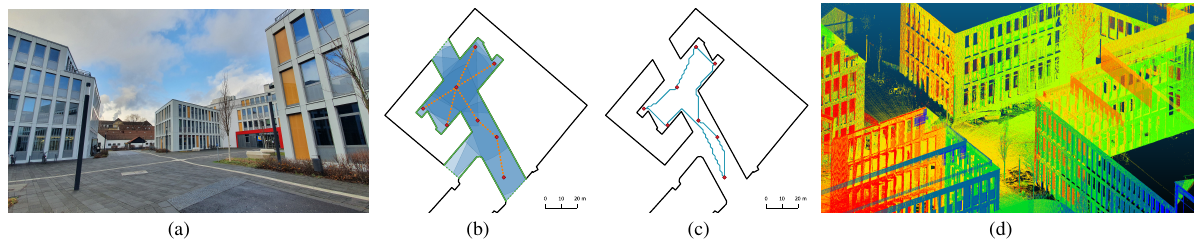
Figure 1. Illustration of the real-world application of our pipeline on the building complex as shown in (a). Given the boundaries of the scene marked by the (dotted) green lines, we compute optimal sensor positionsr (red) based on sensor constraints while simultaneously guaranteeing a full coverage and a satisfactory overlap (depicted by the differently intense colors) for the subsequent registration process (b). This is followed up by the calculation of the optimal route (c) resulting in a point cloud as shown in (d). flow